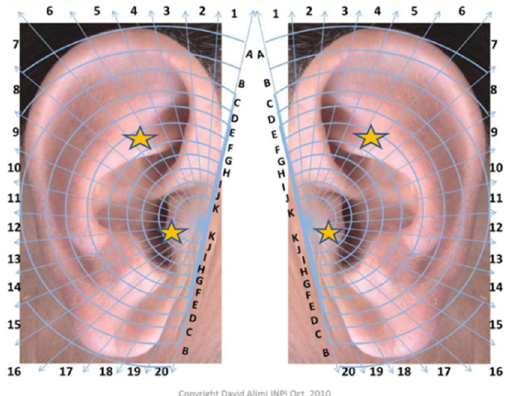
Figure 2. Segmentogram based on French Cartography University/scientific school of Paris (right and left medial auriculogram) from International Auricular Nomenclature. Legend: stars indicate the points applied to the auriculotherapy group (F6 and J13). The laterality chosen was based on the most symptomatic point (right vs. left ear). This cartography was used with permission [31].